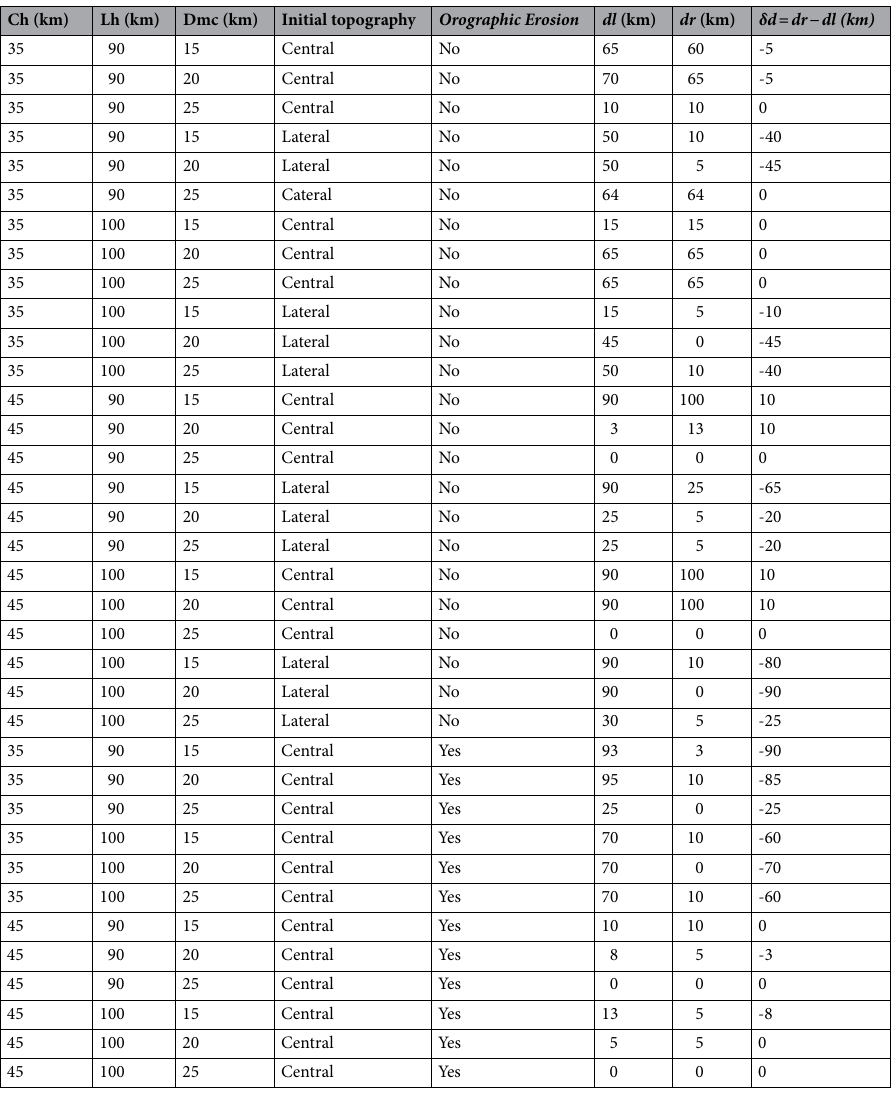
Table 1. Results of the parametric study. Ch Crustal thickness, Lh Lithospheric thickness, Dmc Initial depth of the magmatic channel upper tip dl and dr Maximum horizontal distances between the center of the model domain and the surface fault tips in surface to the left and to the right, respectively; δ d = dr − dl is the degree of the asymmetry of the accumulated bulk strain (negative values show asymmetry to the